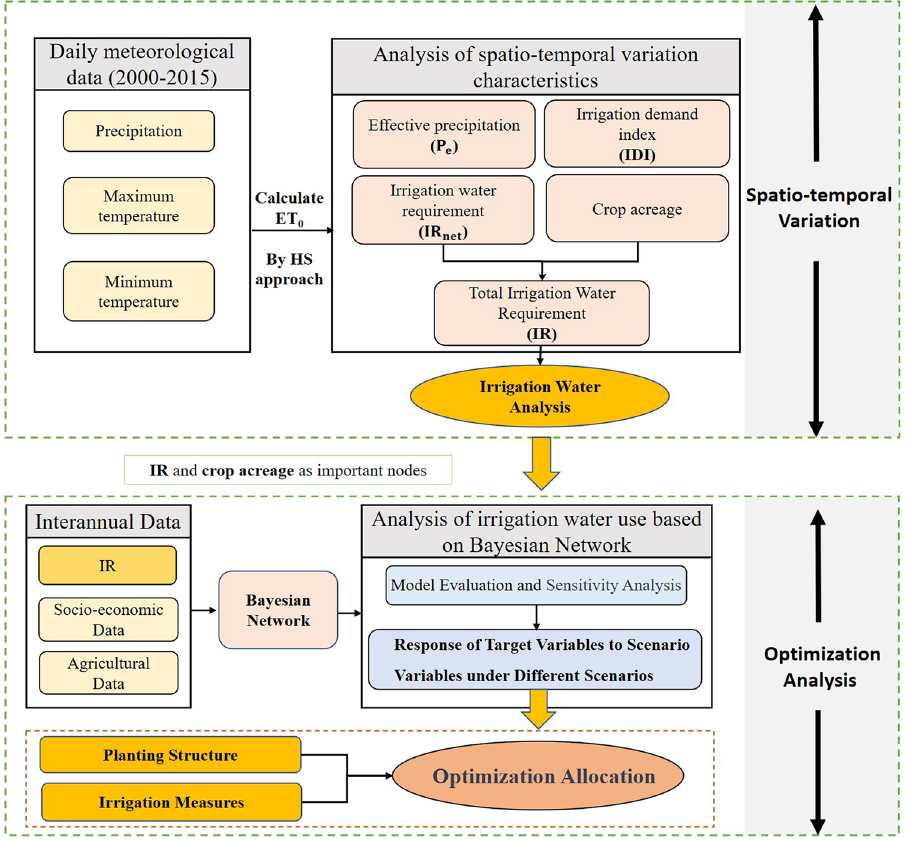
Figure 6. Research approach and technical